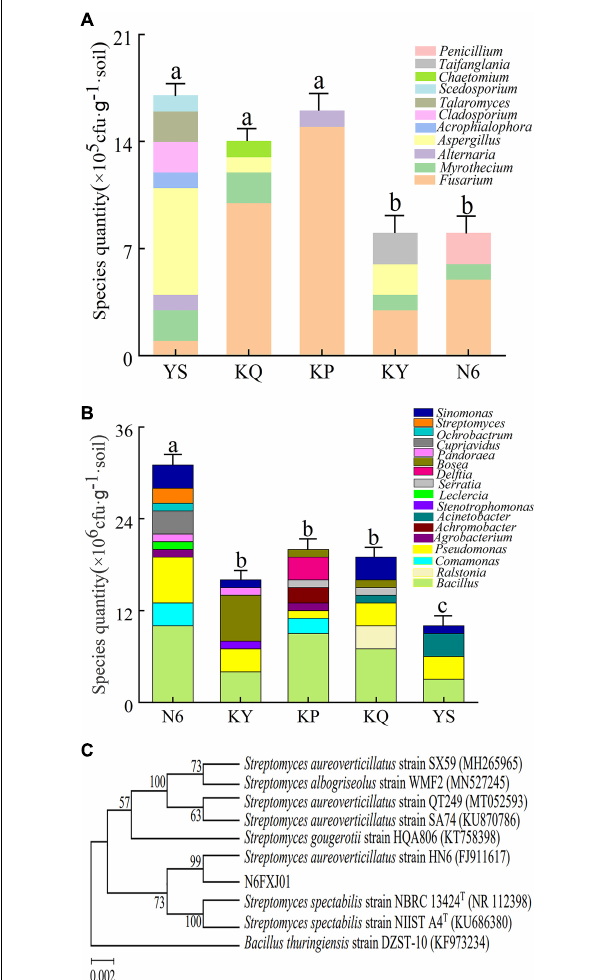
FIGURE 6 | Structural composition of culturable microorganisms in rhizosphere soil. N6 ( Foc · TR4-GFP + HN6, 1.0 × 10 7 cfu g − 1 soil), KY ( Foc · TR4-GFP + 0.1% carbendazim), KP ( Foc · TR4-GFP + Gause No. 1 liquid medium), and KQ ( Foc TR4-GFP + sterile water). YS referred to rhizosphere soil of uninoculated plants. (A) Structural composition of culturable fungi. (B) Structural composition of culturable bacteria. (C) Phylogenetic analysis of strain